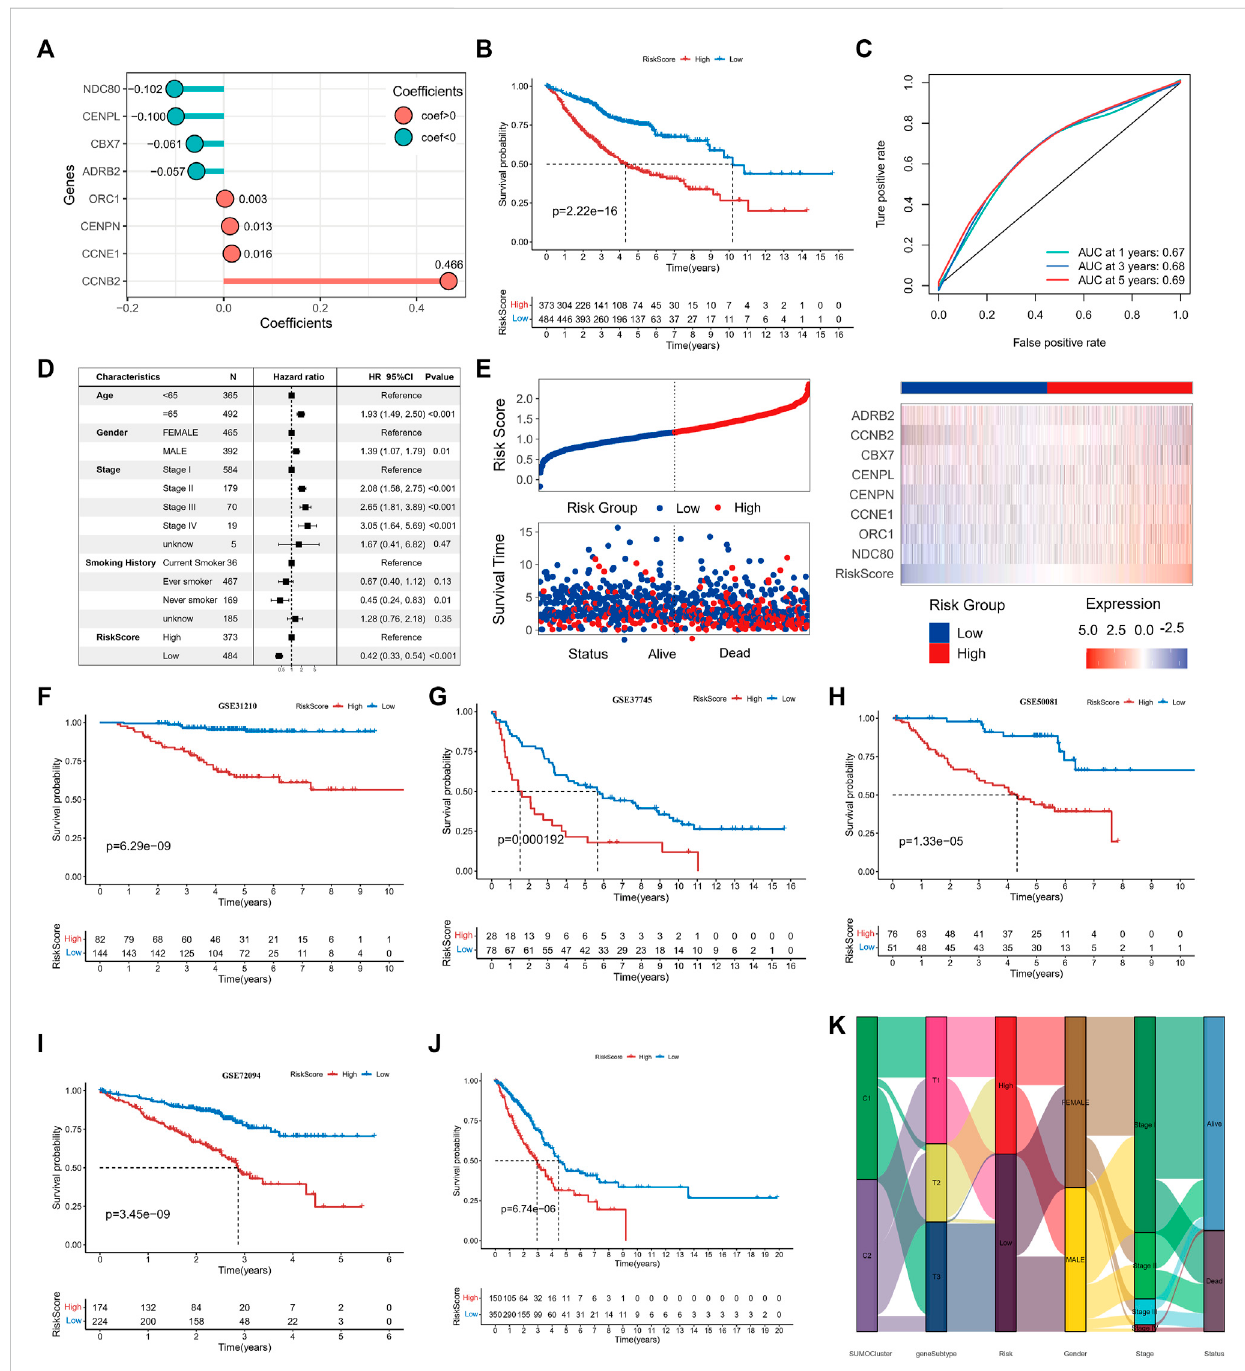
FIGURE 6 Construction of SUMOylation score and validation of prognostic value. (A) LASSO regression coef fi cients of model genes. (B) Kaplan-Meier curves foroverallsurvival(OS)inlungadenocarcinomapatientsbetweenhigh-andlow-SUMOylationscore. (C) Operatingcharacteristiccurveforassessingthe predictive performance of SUMOylation score for OS of lung adenocarcinoma, with AUCs of 0.67, 0.68, and 0.69 at 1, 3, and 5 years, respectively. (D) Multivariate cox analysis indicates that the SUMOylation score can work as an independent prognostic factor for lung adenocarcinoma. (E) The risk heatmap illustrates the variations in SUMOylation scores, patient deaths, and model gene expression levels. Red is high expression and blue is low expression. Validation of the prognostic signi fi cance of SUMOylation scores in independent datasets GSE31210 (F) , GSE37745 (G) , GSE50081 (H) , GSE72094 (I) . (J) Validation of signi fi cant differences in overall survival (OS) between patients with high- and low SUMOylation scores using the TCGA external dataset. (K) The alluvial map reveals the association between SUMOylation patterns, SUMOylation genomic subtypes, SUMOylation score groups, and other clinicopathological prognostic